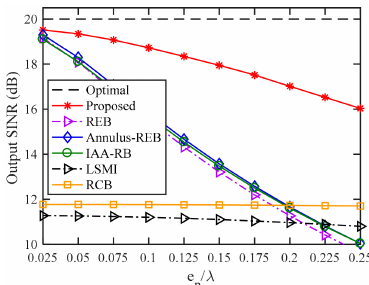
Figure 4. Output SINR versus upper boundary of sensor position